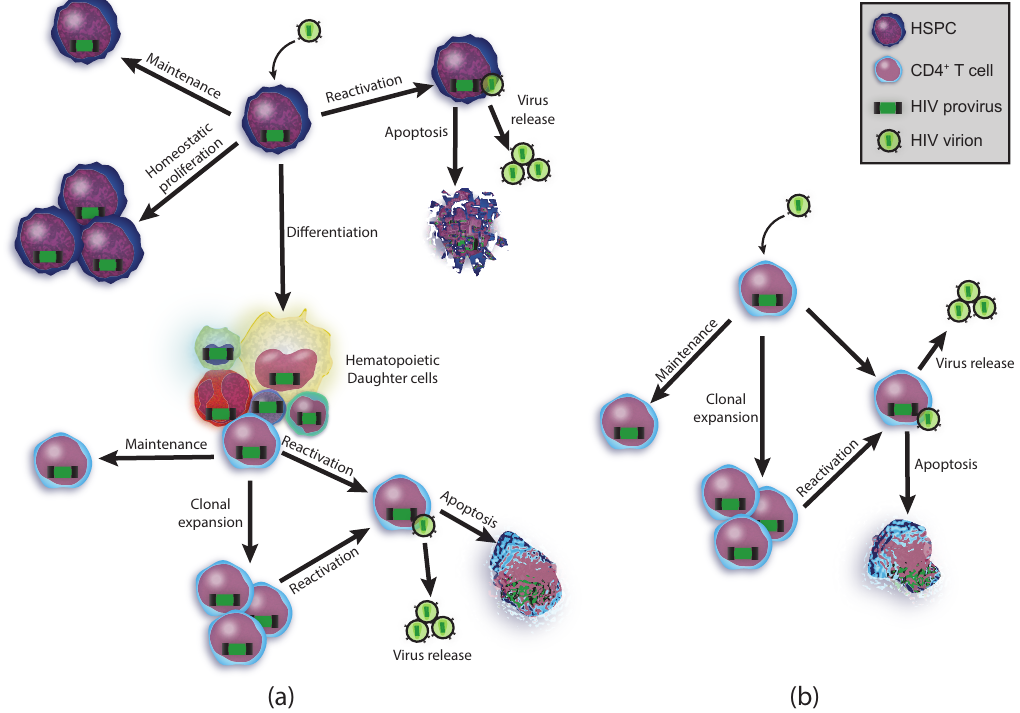
Figure 1. Cellular potential and clonal expansion. ( a ) A hematopoietic stem cell becomes infected with human immunodeficiency virus (HIV) and can follow many fates including maintenance of the population, di ff erentiation, and reactivation (top). Some of the daughter cells can clonally expand (bottom); ( b ) CD4 + T cell fates. A CD4 + T cell becomes infected and can maintain itself, clonally expand, and reactivate to produce more